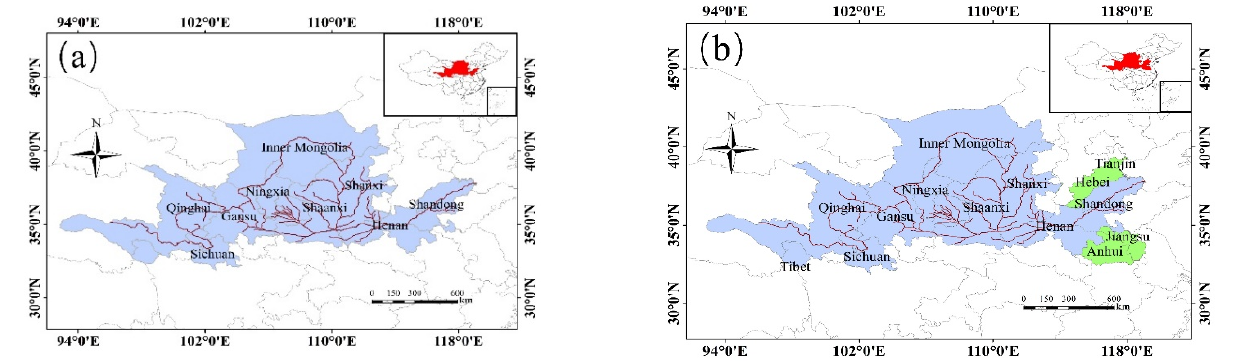
Figure 1. ( a ): The location of the nine provinces and regions in the Yellow River Basin. ( b ): The location of 14 provinces and regions influenced by the Yellow River Basin.